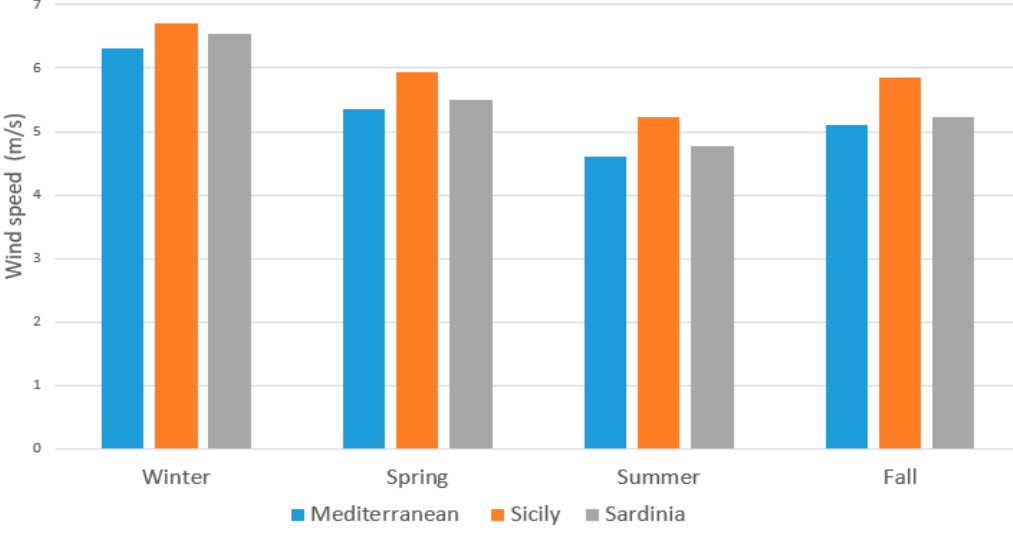
/ s) for case Figure 7. Seasonality wind speed (m/s) for case studies. Figure 7. Seasonality wind speed (m Figure 7. Seasonality wind speed (m/s) for case studies.